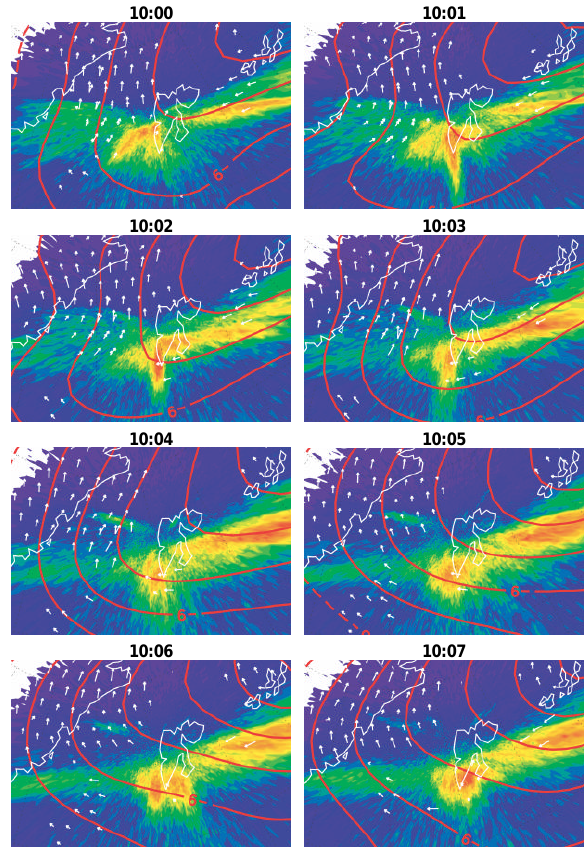
Fig. 8. Sequence of all-sky images of the 630-nm cusp aurora over- laid with the map-potential model output (red contours) and mea- sured flow vectors (white arrows) from the SuperDARN radar net-